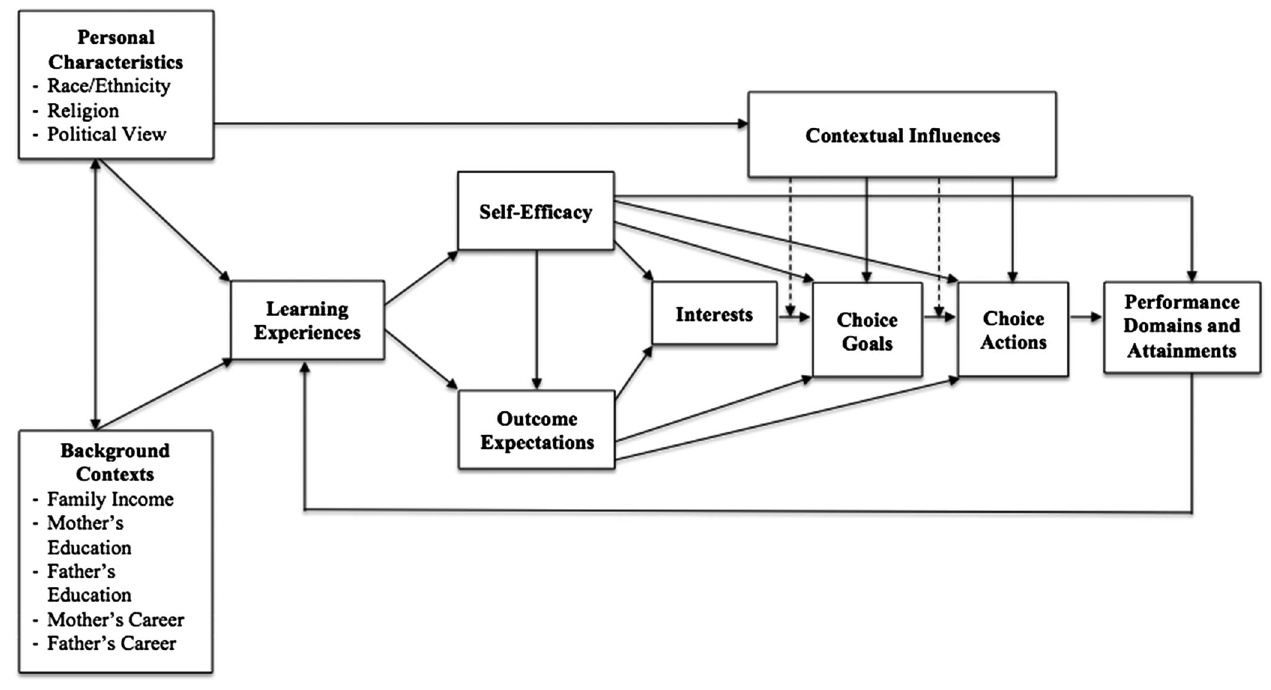
FIG. 1. SCCT adapted from Lent et al.